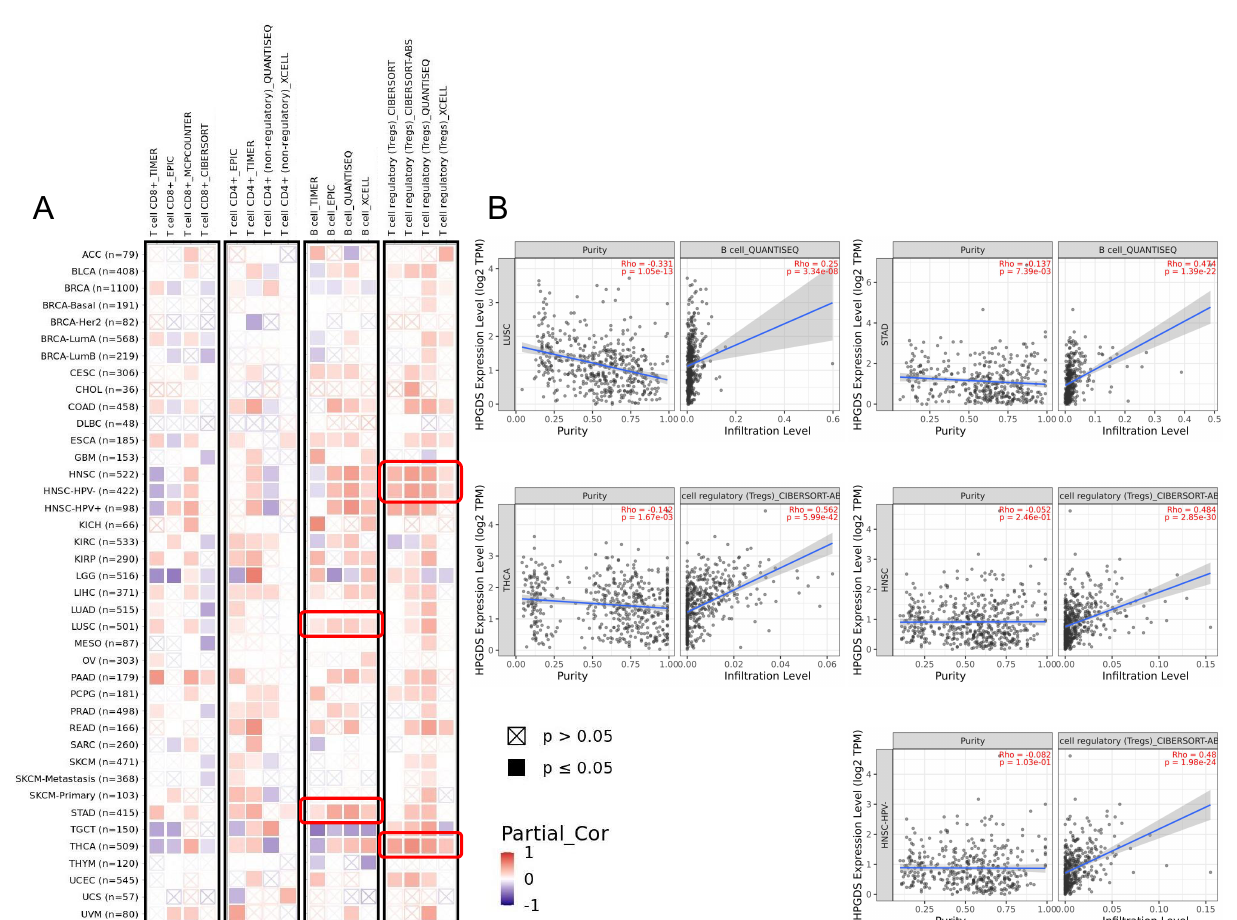
standard Figure 4. Optimization of the liquid–liquid extraction method. Values are the means ± deviations; n = 3 parallel determinations. a–c Mean values (a > b > c, corresponding to the same immune cells. ( A ) Multiple algorithms were used to explore potential correlations between the parameter) not followed by a common letter differ significantly ( p < 0.05). expression of HPGDS and the infiltration of cancer associated CD8 + T cells, CD4 + T cells, B cells, − and Tregs across all types of cancer in TCGA. ( B ) The results with the highest correlation scores, as verified by multiple algorithms, are